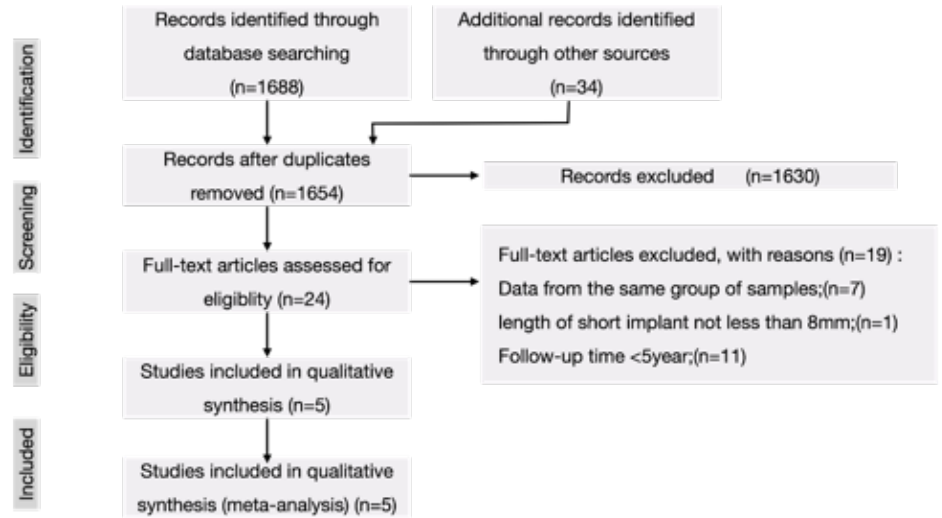
Figure 1. The search strategy of the present study according to PRISMA guidelines.